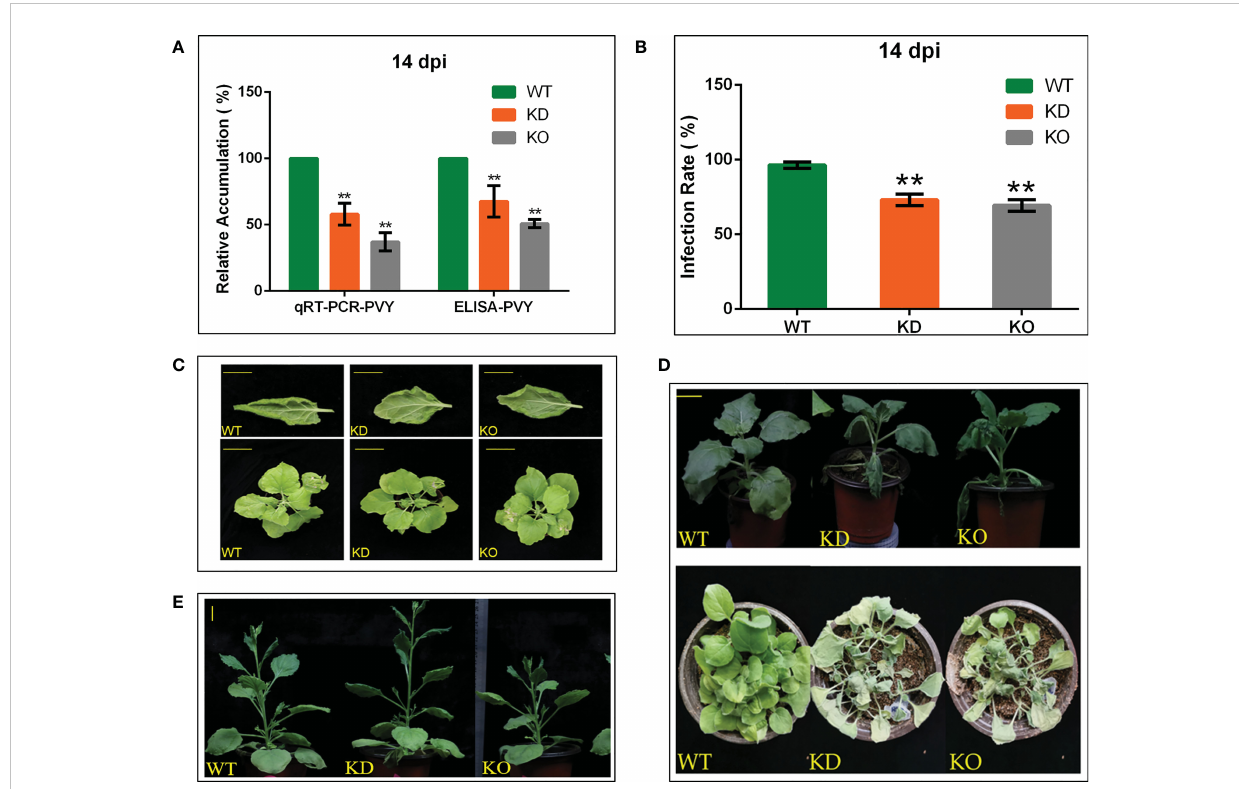
FIGURE 3 NbBI-1 promotes PVY accumulation, infection, symptoms and NbBI-1 knockout reduces resistance to drought and cold stresses. (A) NbBI-1 promoted PVY accumulationin N. benthamiana . The relative RNA level of PVY was detected by qRT-PCR in PVY-infected plants. GAPDH was used as an internal reference. The relative accumulation of PVY in the leaves of plants was detected by ELISA. Leaves were collected 14 days after PVY infection. (B) NbBI-1 decreased resistance to PVY infection. After 14 days, WT, OK, and KD infected with PVY were selected to observe symptoms and to count the infection rate. (C) NbBI-1 promoted the pathogenicity of PVY. After 14 days, WT, OK, and KD infected with PVY were selected to observe and photograph. Row 1, bar, 1cm;Row 2, bar, 3 cm. (D) NbBI-1 knockout reduced resistance to drought. Take photos for the record after 10 days of stopping watering (Row 1, 4-week-old plants, bar, 2 cm; Row 2, 2-week-old plants). (E) NbBI-1 knockout reduced resistance to cold. Take photos for the record after 2 months of culture at 10 °C (4-week-old plants, bar, 2 cm). Data are mean ± SEM, asterisks indicate a signi fi cant difference (Student ’ s t-test, test, **: